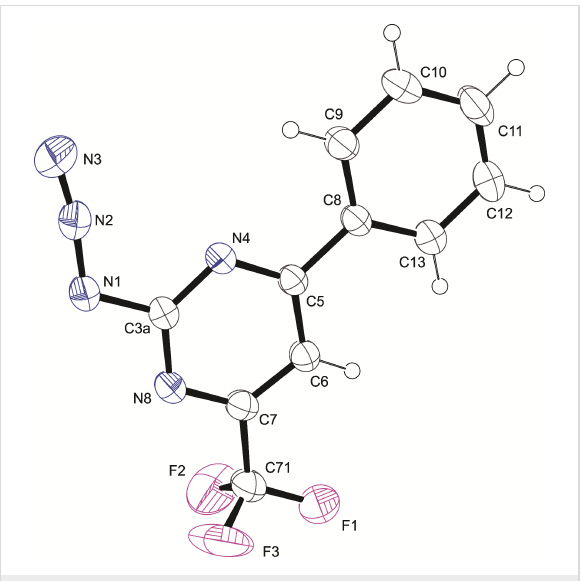
Figure 4: ORTEP ® [45] plot of 7a with thermal ellipsoids drawn at 50% probability level.